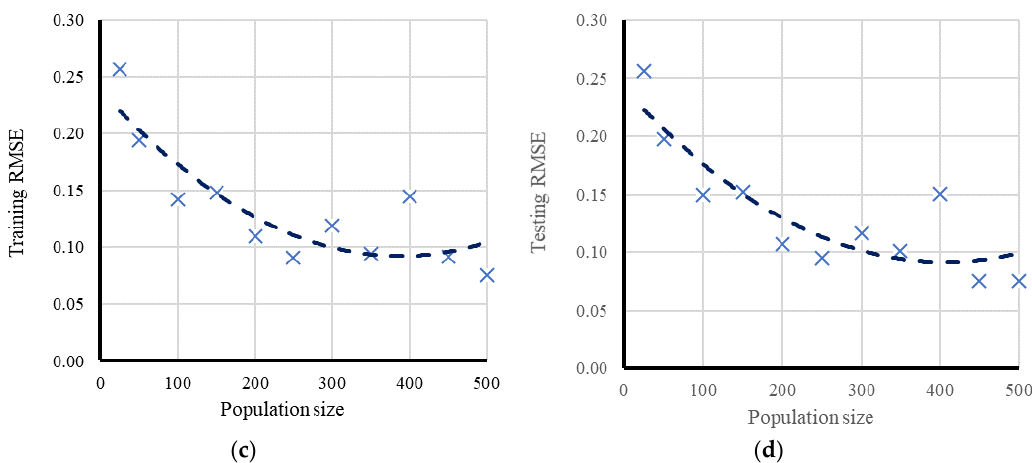
Figure 12. The results of network performance for the PSO–ANN vs. population size, ( a ) training R 2 , ( b ) testing R 2 , ( c ) training RMSE, ( d ) testing RMSE.